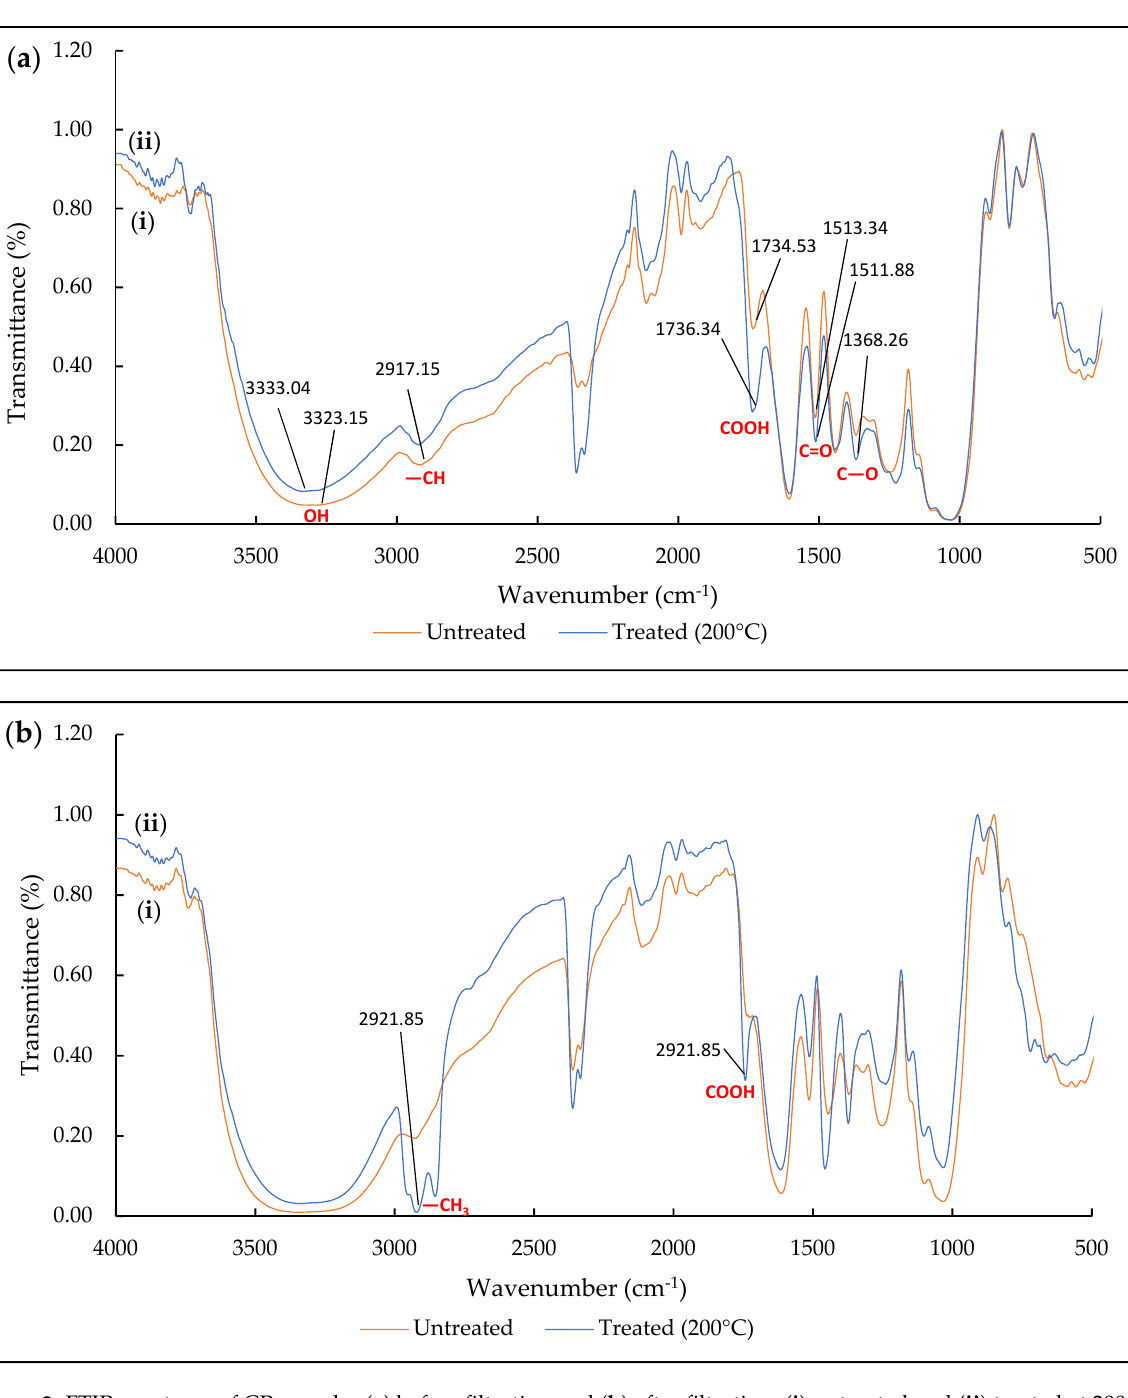
Figure 2. FTIR spectrum of CP samples ( a ) before filtration and ( b ) after filtration: ( i ) untreated and ( ii ) treated at 200 °C. Figure 2b reveals the FTIR spectrum for CP samples after diesel–seawater treatment. The stretching of the alkyl group was wider after filtration. This peak is relatively associated with the alkyl (CH 3 ) long chain of diesel hydrocarbons, which is greatly reflected in T CP (2921.85 cm − 1 ) [49]. The ester linkage of the carboxyl group was identified at 1742.83 cm − 1 for T CP, but none was detected for UNT